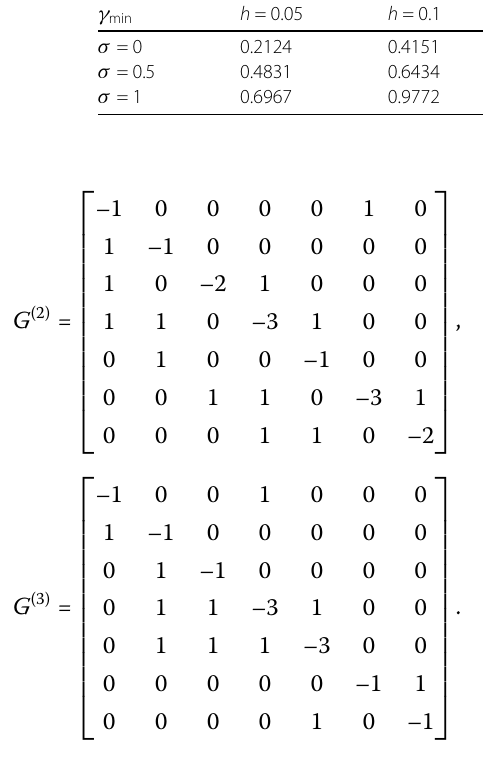
Table 1 Minimum allowable values of γ for mixed H ∞ and passivity analysis satisfied with different values of h and